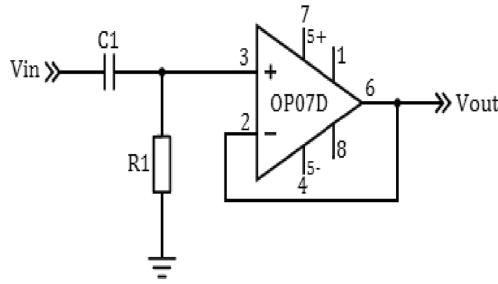
Fig. 1 Hardware system components